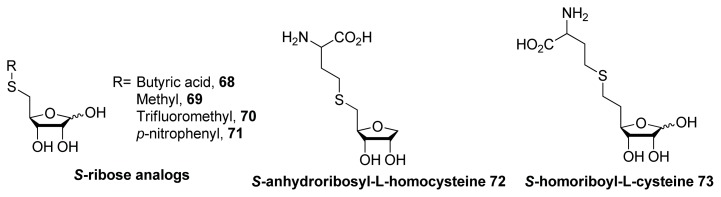
SRH analogs prepared by Zhou and co-workers [97,98].